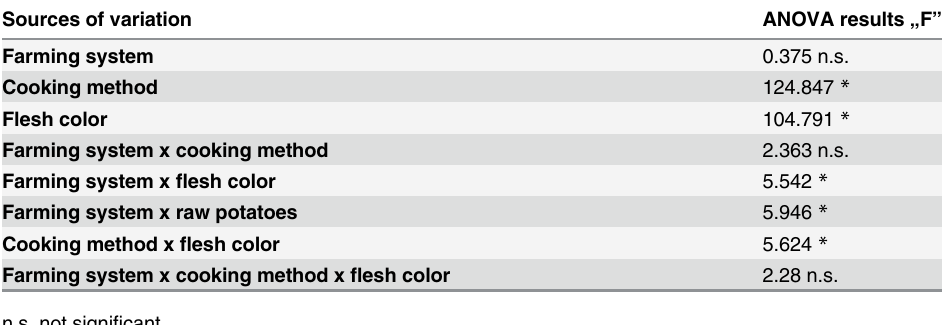
Table 6. Sources of variation and ANOVA results „ F ” for effect of different cooking methods and flesh colors on total phenolic contents in potato tubers (see Table 5). Sources of